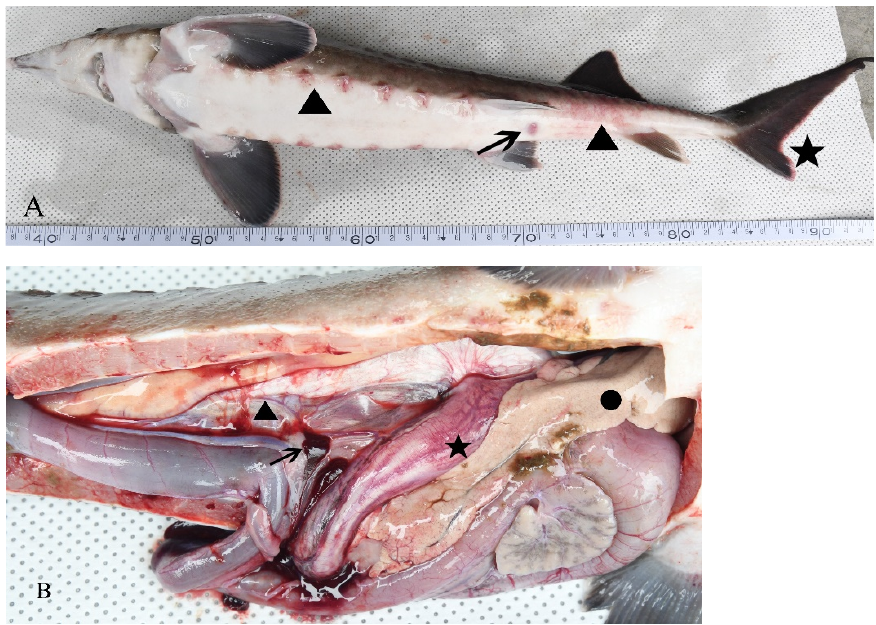
Figure 1. Clinical symptoms of an H-701-infected hybrid sturgeon: ( A ) Body surface (triangle), cloacal orifice (arrow), and fin (asterisk); ( B ) Ascites (triangle), liver whitening (dot), intestinal wall bleeding (asterisk), and spleen redness (arrow).